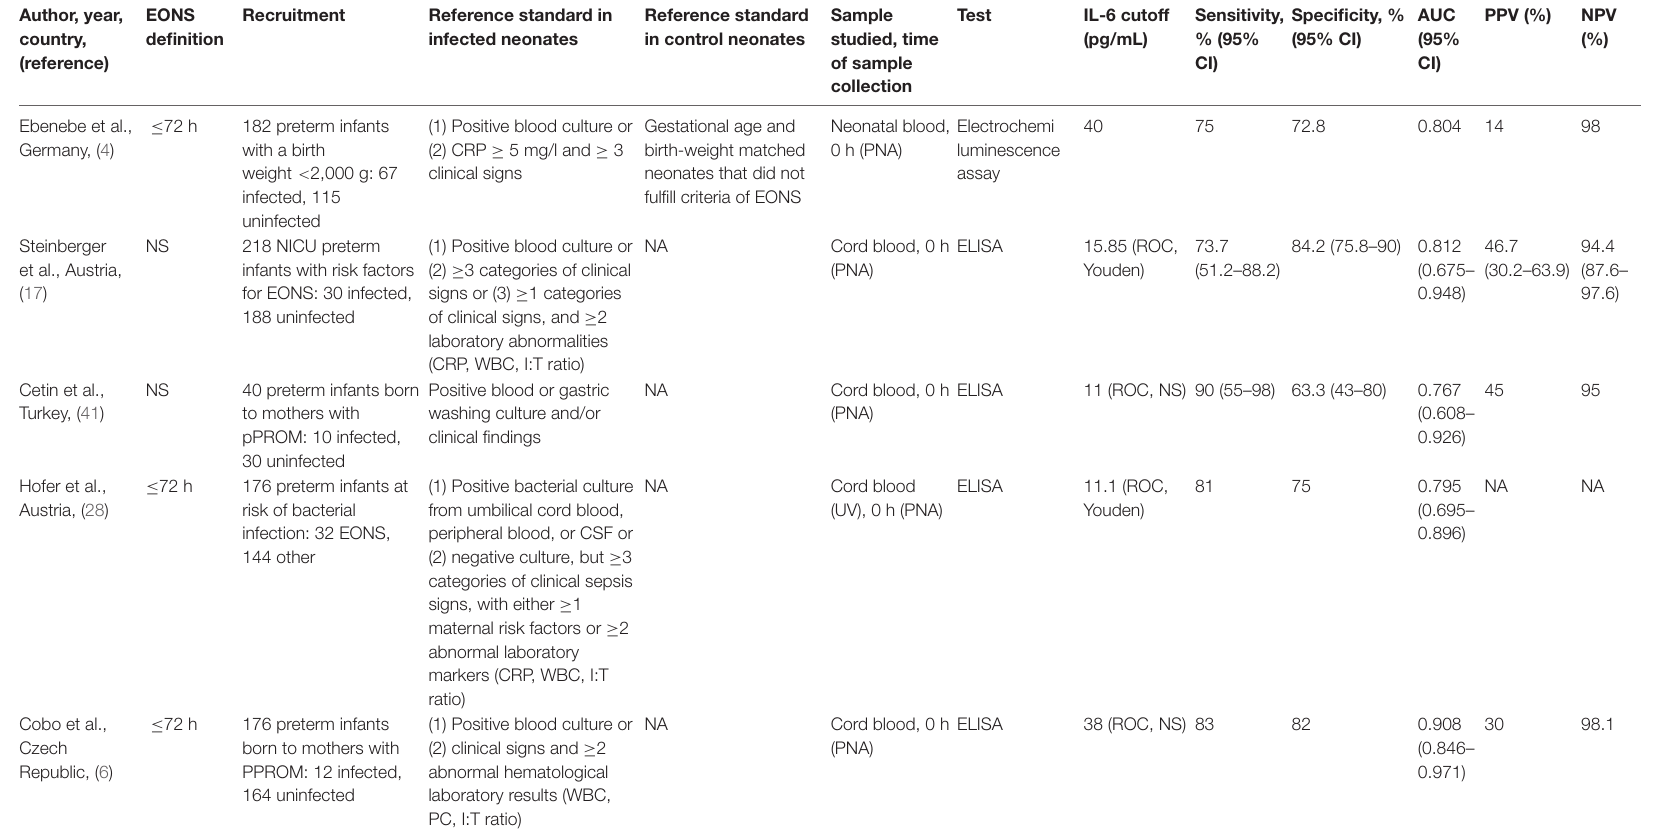
TABLE 1 | Characteristics of IL-6 accuracy studies for diagnosing EONS in the preterm infant. Author, year,